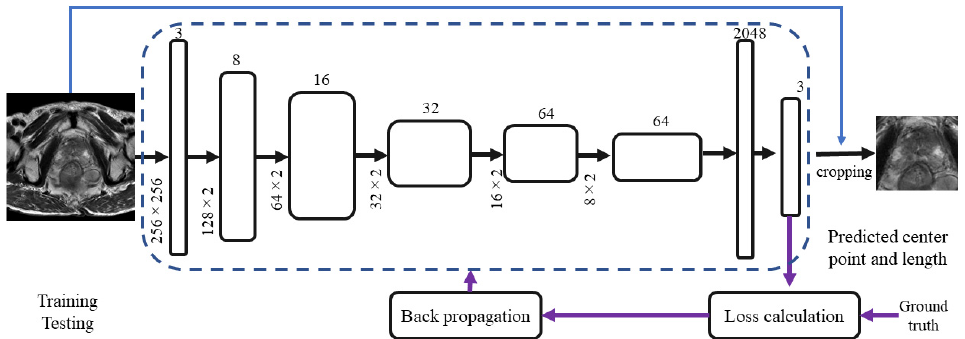
Figure 3. The figure shows the prostate detection and cropping procedure used in this paper. In the step of CNN-based prostate region detection, each rectangular box in the figure represents a feature map vector and shows the dimensional information of the feature map, the lower left corner of each feature map shows the length and width of the feature map, and the top shows the number of channels of the feature map. After this network, three output parameters can be obtained: the center coordinates ( x , y ) of the detected square region containing the prostate and the length of the square region L.